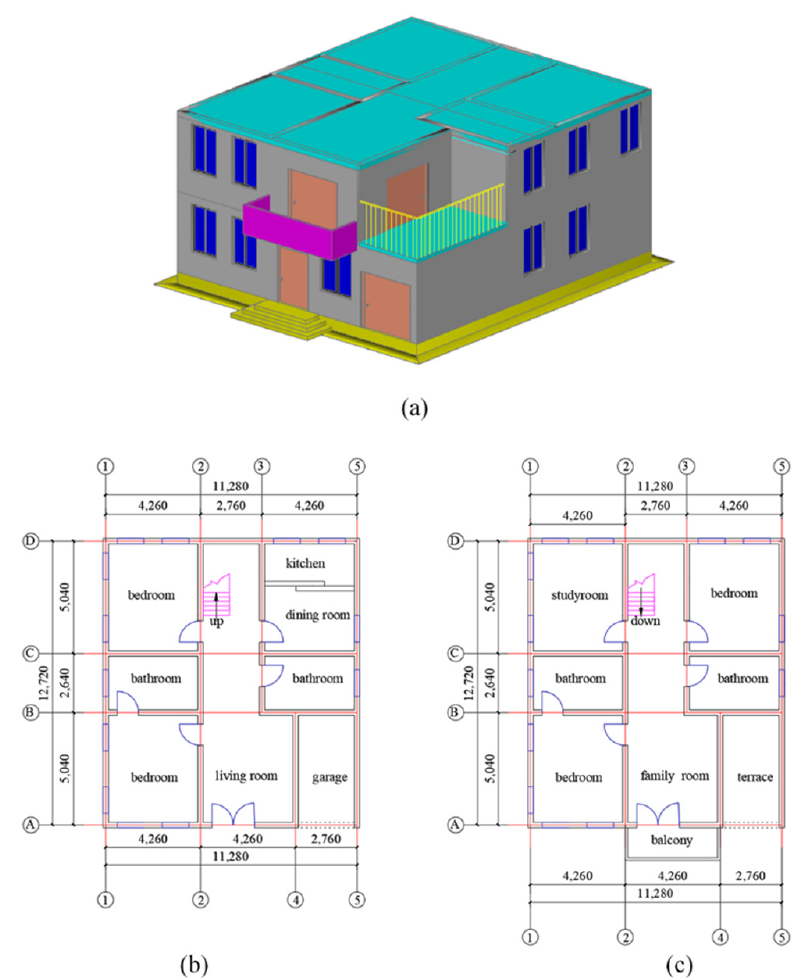
Figure 8. Architectural design scheme of design example: ( a ) 3D schematic diagram of the building, ( b ) first floor, and ( c ) second floor.